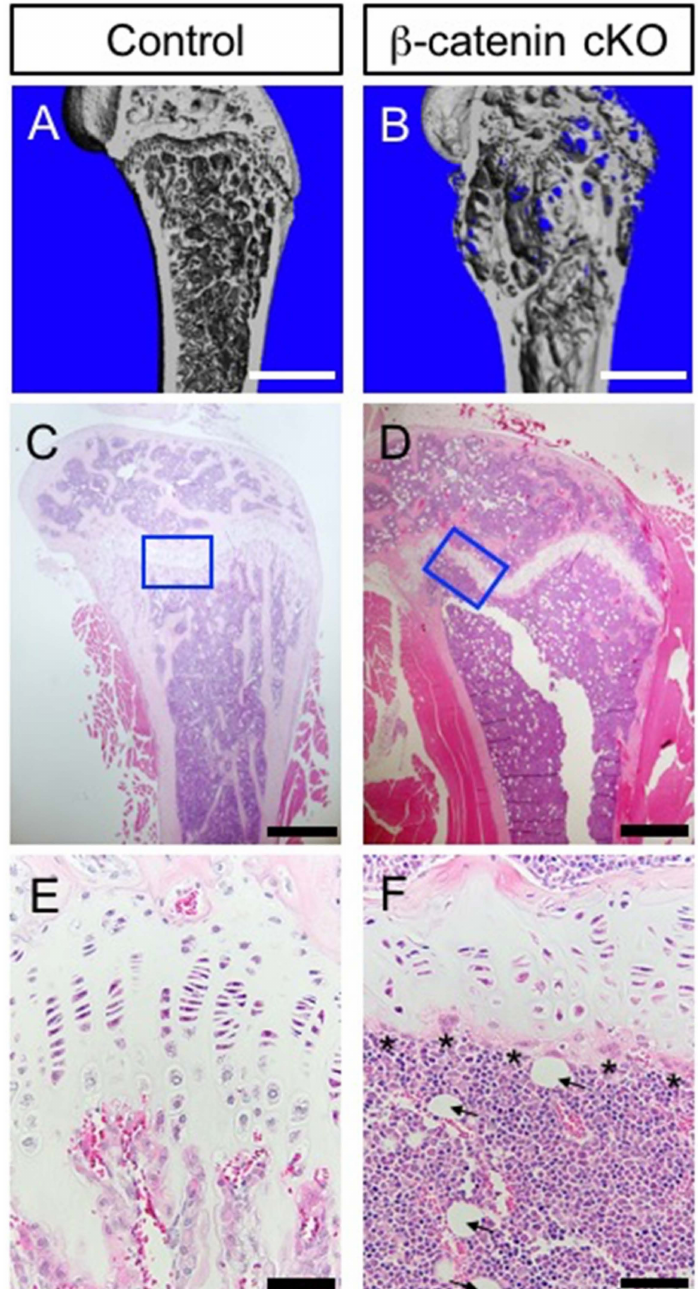
Figure 4. Loss of β -catenin gene in growth plate derived Hh-signal responded cells results in osteopenia and fatty bone marrow. ( A , B ) Longitudinal view of µ CT images in distal femur from control and Gli1-CreER; β -catenin c / c ( β -catenin cKO). Control and β -catenin cKO littermate mice were treated with tamoxifen at 4 weeks of age and analyzed after 10 weeks to inactivate the β -catenin gene. µ CT imaging revealed that β -catenin deletion resulted in an abnormal bone formation in the distal femur. ( C – F ) Representative images of femur stained with hematoxylin and eosin. ( E , F ) Higher magnification of blue boxes in ( C , D ). Histology revealed a lack of trabecular bone under the abnormal growth plate of β -catenin cKO mice ( D , F ). This bone phenotype was likely due to increased osteoclastic bone resorption (F, Asterisks mark increased osteoclasts). Histology of the femur also indicated a significant increase in adipocytes at the metaphysis (F, arrowheads show). Scale bars indicate 1 mm ( A , B ), 500 µ m ( C , D ) and 50 µ m ( E , F